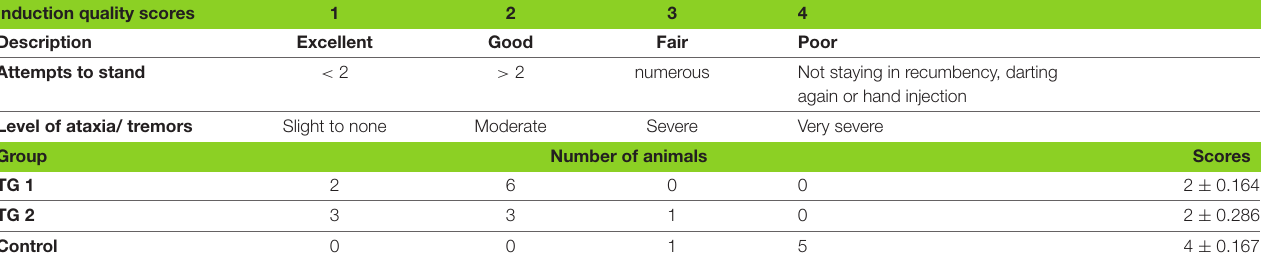
TABLE 2 | Distribution of scores that represent the quality of induction in TG a 1: ketamine–medetomidine–midazolam–butorphanol (KMMB), TG 2: tiletamine–zolazepam–medetomidine–butorphanol and CG b : etorphine–acepromazine–detomidine–butorphanol (EADB) immobilized kulans (Equus hemionus kulan). Induction quality